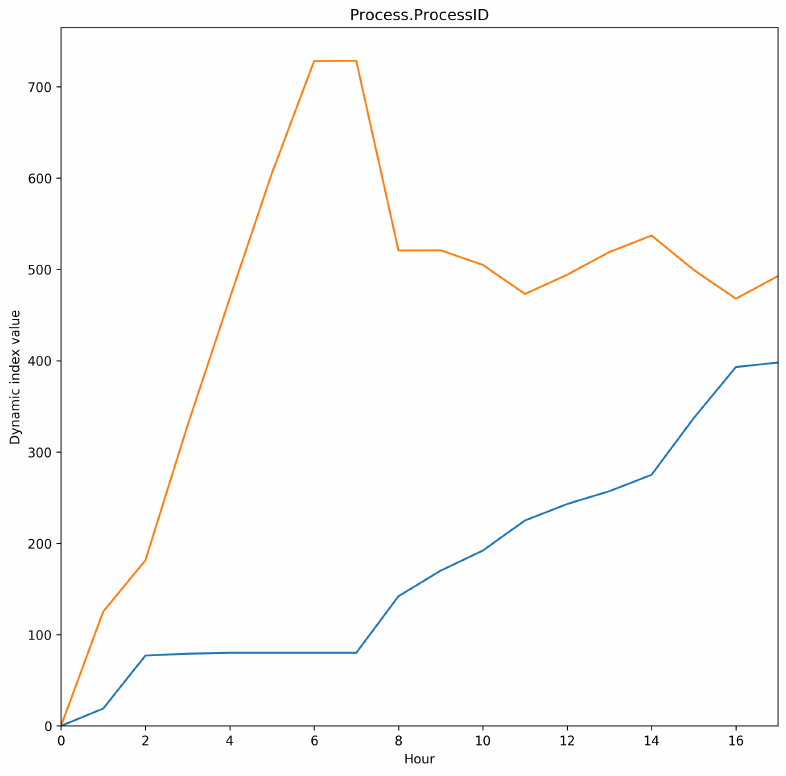
Figure 9. Dynamic indexes for the Process.ProcessID event